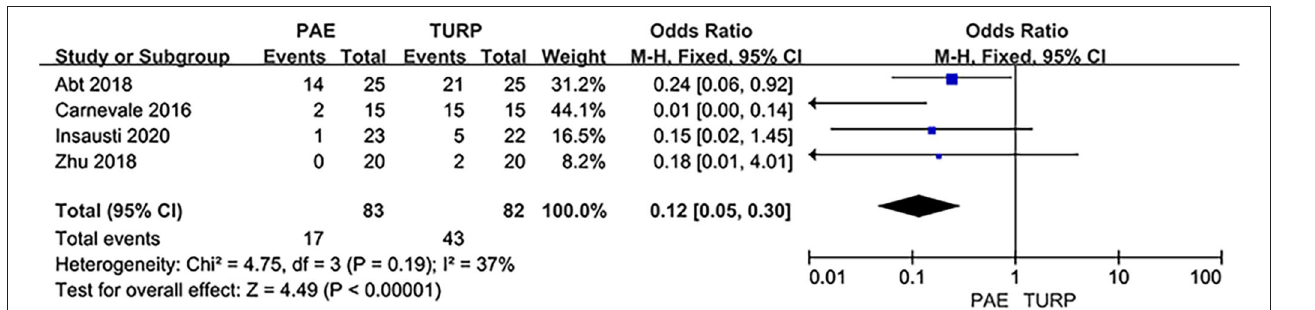
FIGURE 9 | Forest plot for sexual